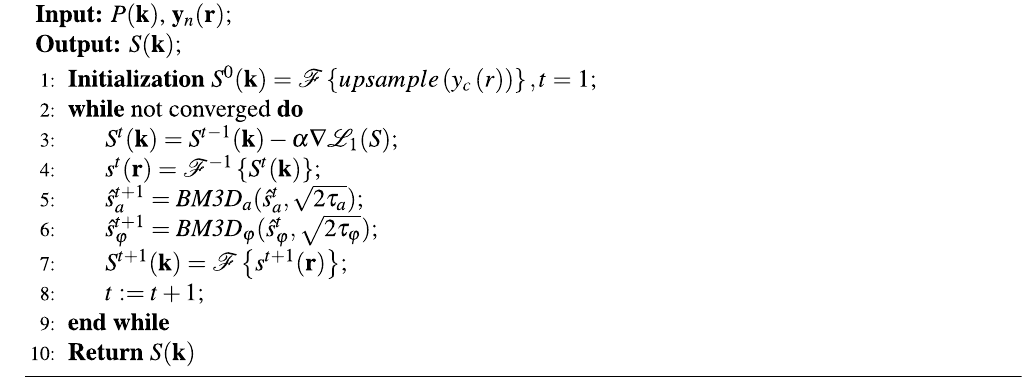
Algorithm 1. Fourier ptychographic microscopy with sparse